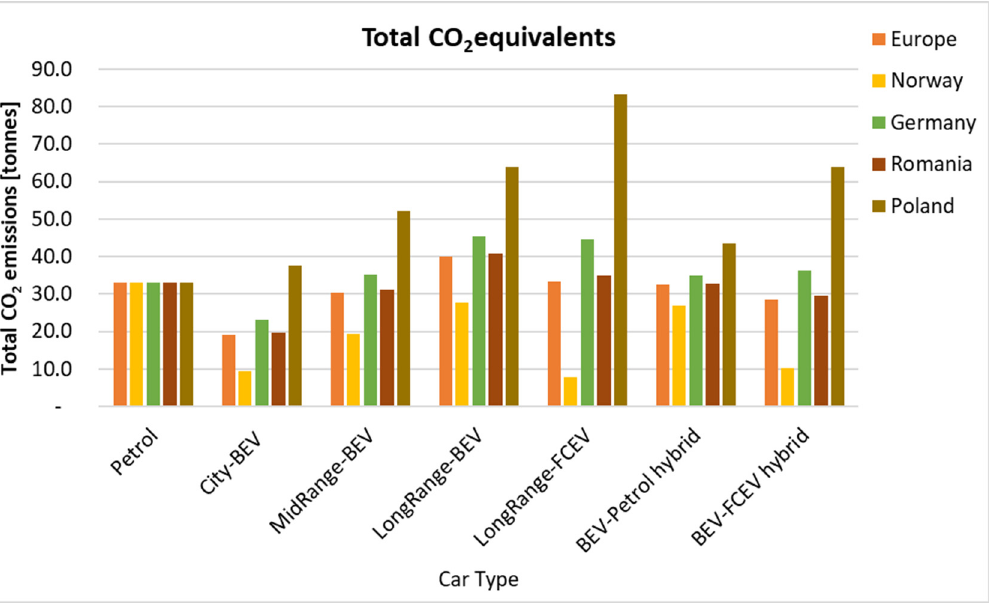
Figure 6. ( a ) Energy production from primary sources for Poland for 2021. ( b ) total CO 2 emissions for 2021 for Poland for different types of cars, including car and battery production as well as running of the vehicle considering different sources for energy production.